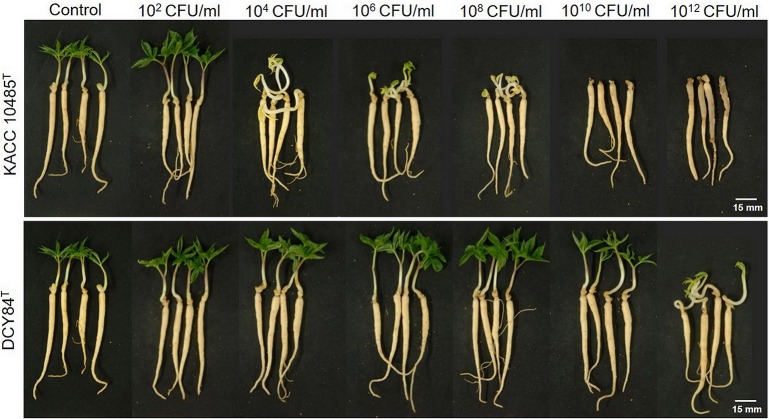
Ginseng pot assay for in planta compatibility testing of strain DCY84T on P. ginseng. Symptoms in ginseng seedlings were measured 7 days after bacterial treatment using various CFU/mL inoculants in a soil system. P. polymyxa KACC 10485T and P. yonginensis DCY84T were used in this test. Root rot symptoms did not appear, but some stressed/redundant growth was observed. White scale bar indicates 15 mm.